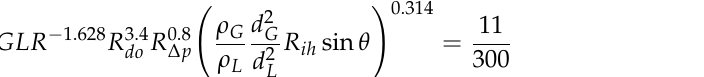
Figure 6. The quality of the generated spray depends on the structure of the internal flow [84]. Kourmatzis et al. [47] analyzed the hybrid atomization (effervescent and air-blast at- omization) and showed that the air-blast mode has a significant impact on the sizes of generated ligament at the exit orifice for GLR equal to <2.7%. Experimental data shows that the coaxial flow makes it possible to entrainment of air in the central core, thereby influencing the degree of atomization and dispersion in relation to the pure effervescent mode.